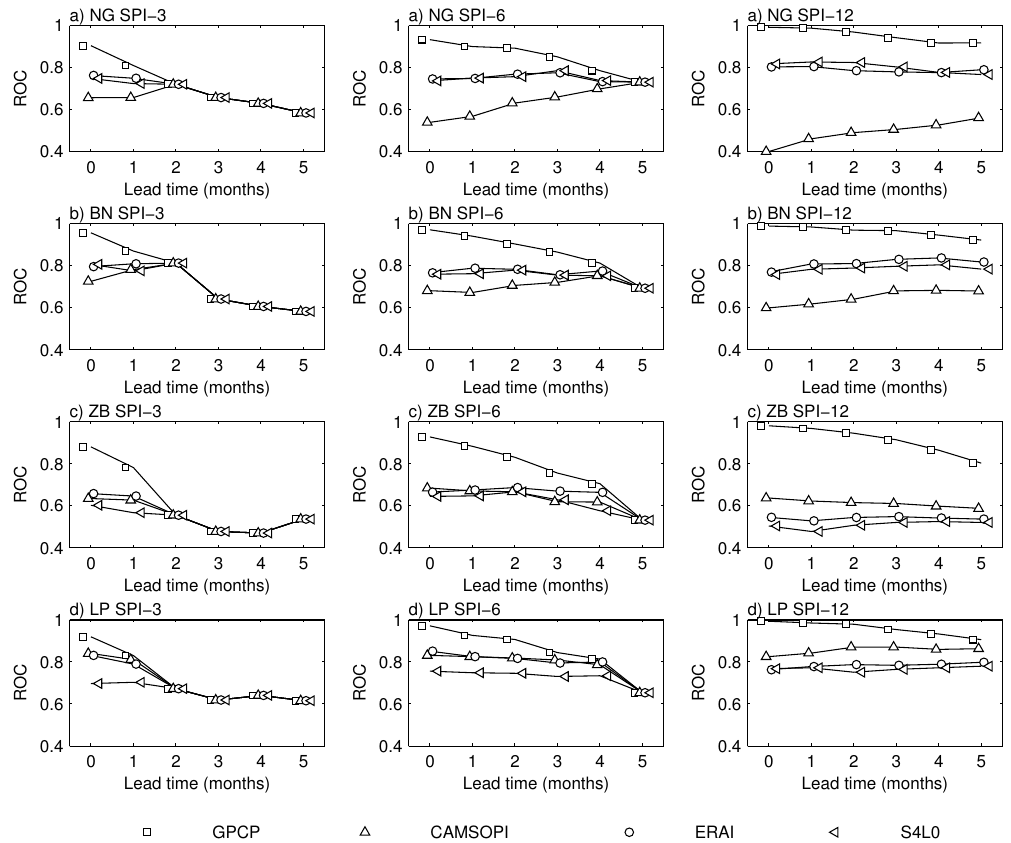
Fig. 11. Relative operating characteristic (ROC) of the S4 SPI forecasts as a function of lead time (months) for different timescales (columns) and for the four basins (rows). Each panel compares the ROC of S4 forecasts using GPCP (square symbols), CAMS-OPI (triangle up symbols), ERAI (circle symbols) and S4L0 (triangle left symbols) as monitoring. Note that for the SPI-3 all ROC scores are the same from 2 months lead time onwards and for the SPI-6 for 5 months lead time since in those lead times only S4 precipitation is